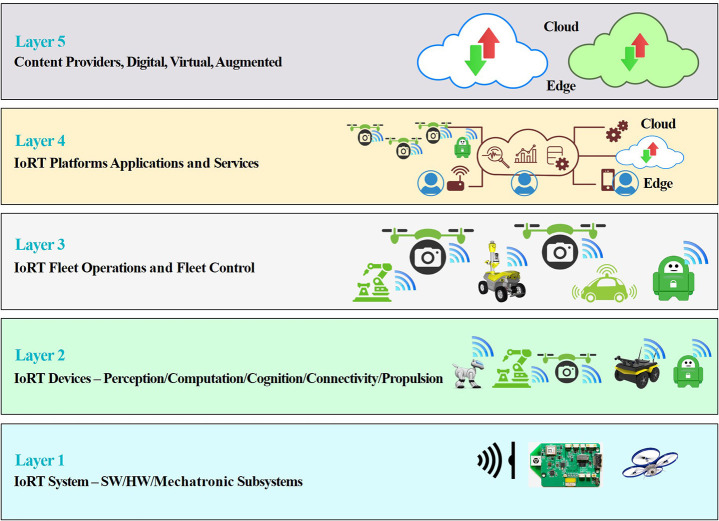
Stack of layers covered by the IoRT functional components.